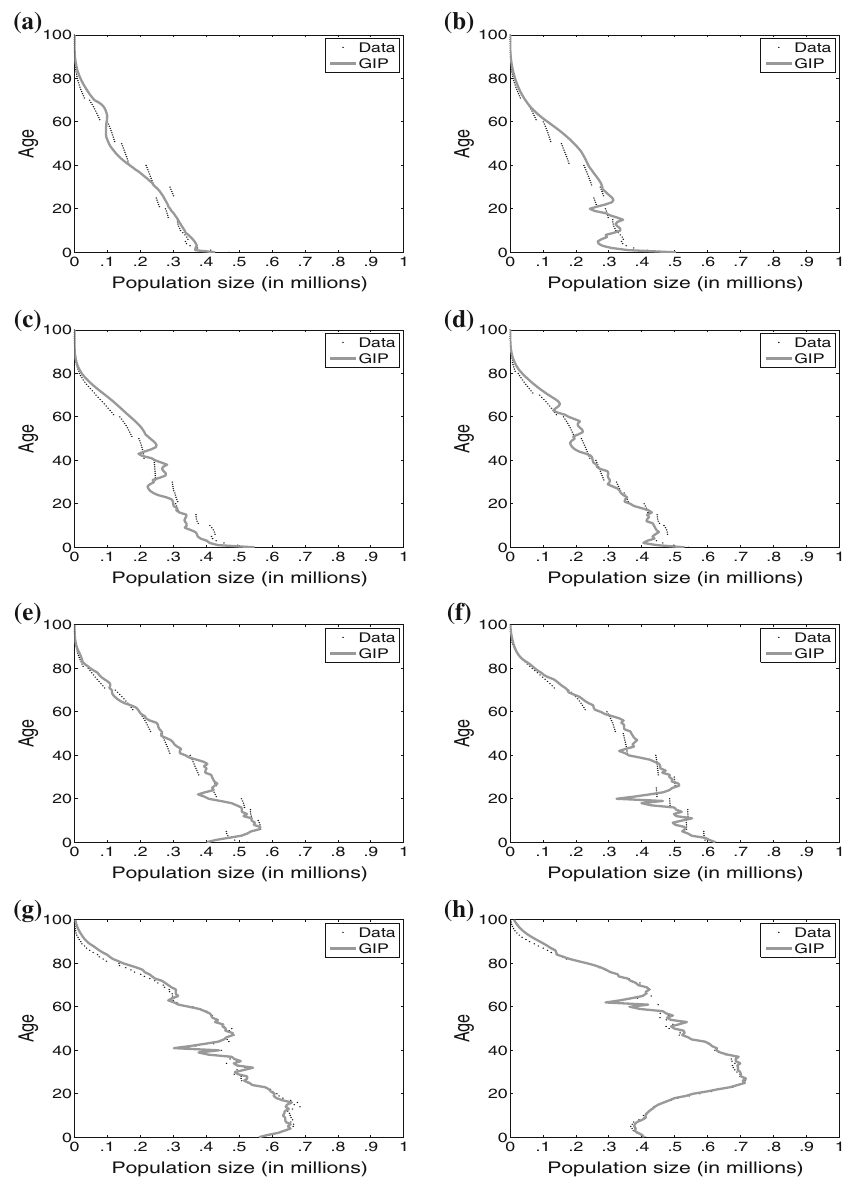
Fig. 10 In-sample performance of the GIP model to existing census data. Spain: Selected year between 1857 and 2002. a Census 1857, b census 1877, c census 1900, d census 1920, e census 1940, f census 1960, g census 1980 and h census